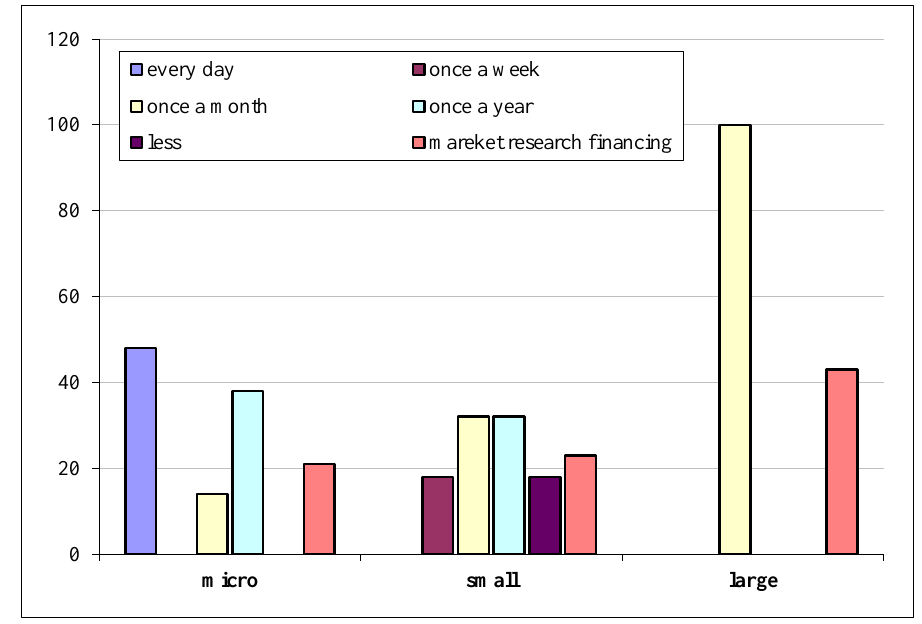
Figure 8. Issue of market research and its